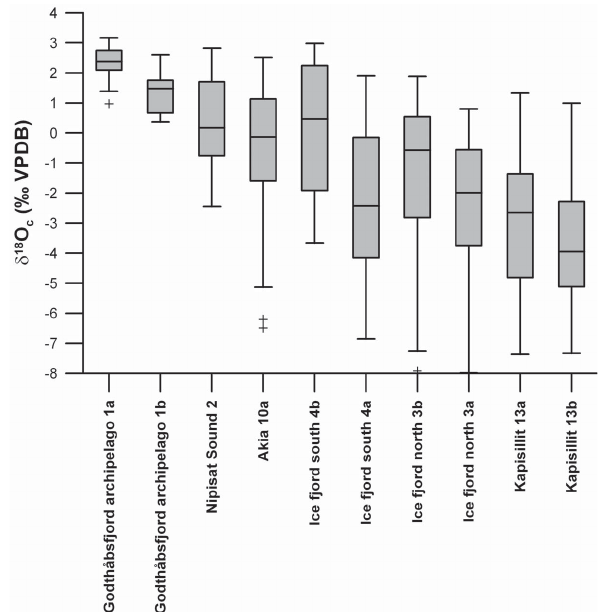
Fig. 3. Box and whisker diagram of δ 18 O values of all shells. Grey boxes are 50% of data, whiskers 25% of data each; outliers are in- dicated with + symbols. At the left side of the graph are the shells that were collected closest to the open ocean and show least influ- ence of freshwater in their δ 18 O c values. At the right side are the shells collected closest to the glacier, with most profound freshwa- ter influence on their δ 18 O c